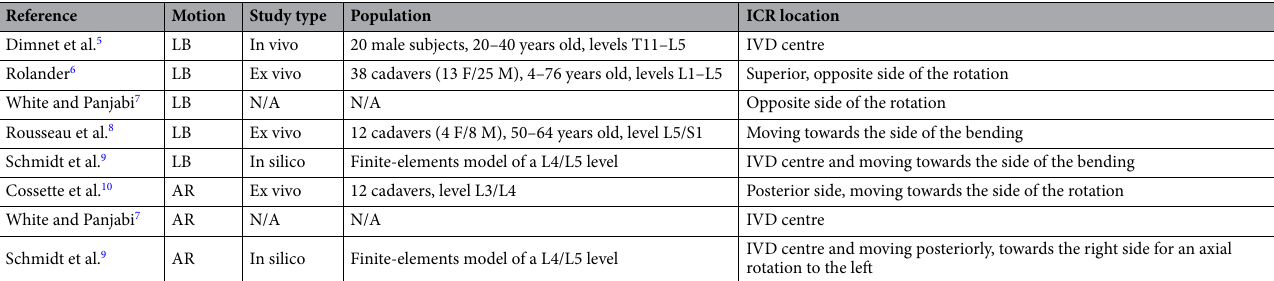
Table 1. Summary of studies on the ICR location during lateral bending and axial